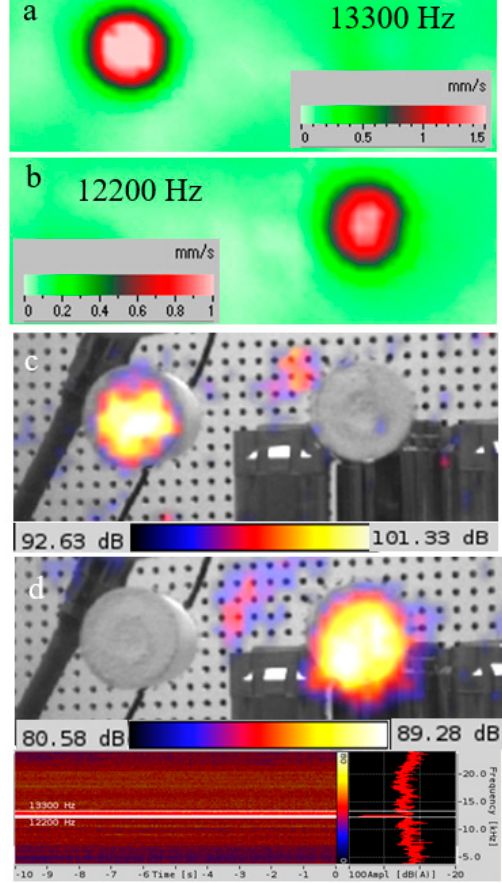
Figure 20. Laser vibrometry ( a , b ) and frequency-selective full-field AE imaging ( c , d ) of a pair of circular FBH of close LDR frequencies.